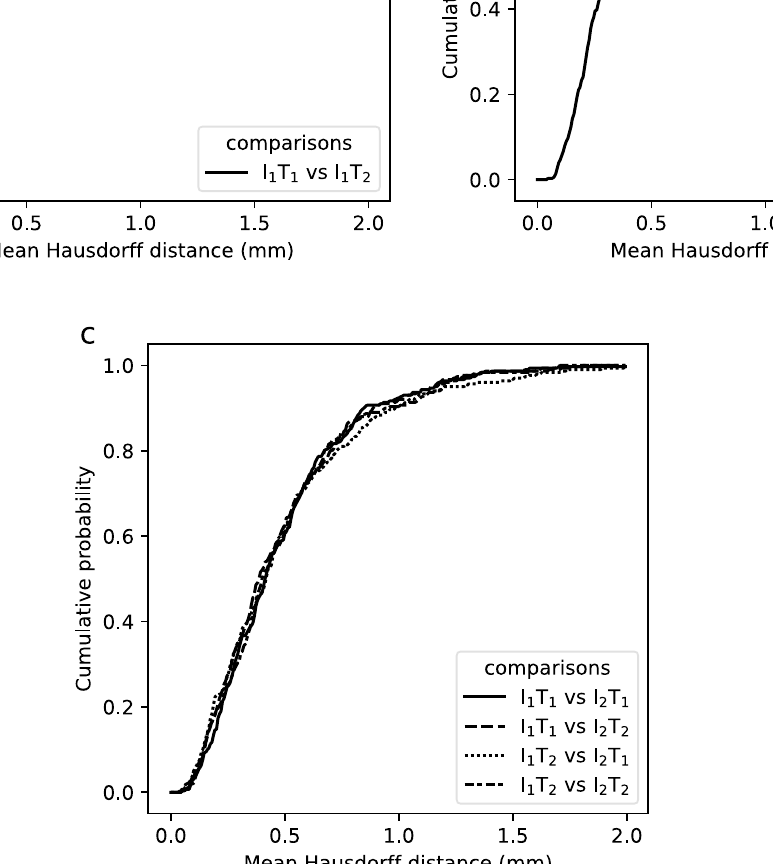
Figure 8. Registration accuracy measurements based on the distance between identical meshes from different registrations. The diagrams show the cumulative probabilities of mean distances between meshes for each comparison. ( a ) and ( b ) shows the intra-rater comparison of I 1 (I 1 T 1 vs I 1 T 2 ) and I 2 (I 2 T 1 vs I 2 T 2 ) respectively. ( c ) shows the inter-rater